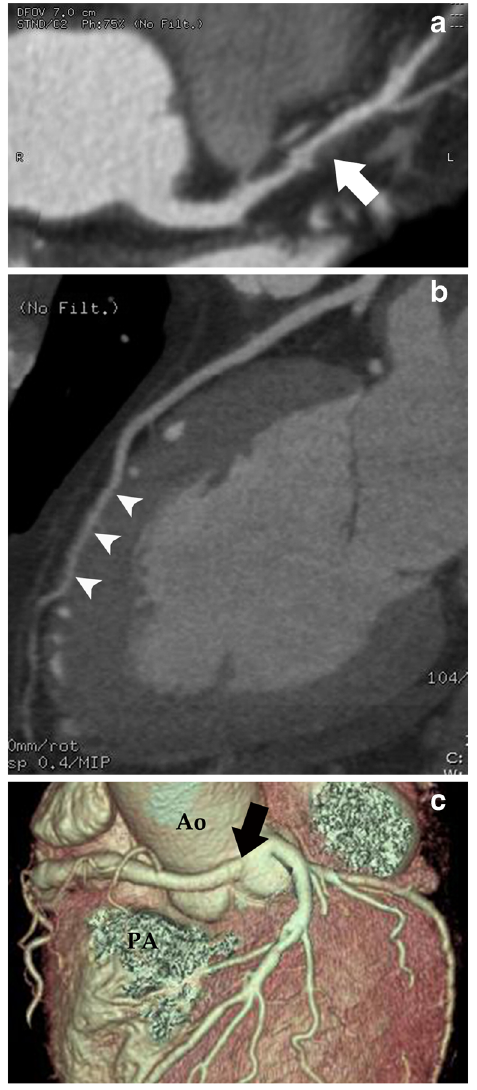
Fig. 1 Different kinds of computed tomography coronary angiography (CTCA) images showing examples of coronary diseases. a Transverse curved planar reformatted (CPR) image showing a non-calcified plaque in the mid-segment of the left anterior descending coronary artery ( arrow ), causing a significant (> 50%) stenosis. b CPR image along the left ventricle vertical long axis showing a 3-cm-long myocardial bridging ( arrowheads ) of the mid-distal third of the left anterior descending coronary artery. c Three-dimensional volume rendering image showing the origin from the left Valsalva sinus of the right coronary artery ( arrow ), which reaches the right atrium-ventricular path, coursing between the aorta root ( Ao ) and the pulmonary artery root (cut – PA ) (malignant